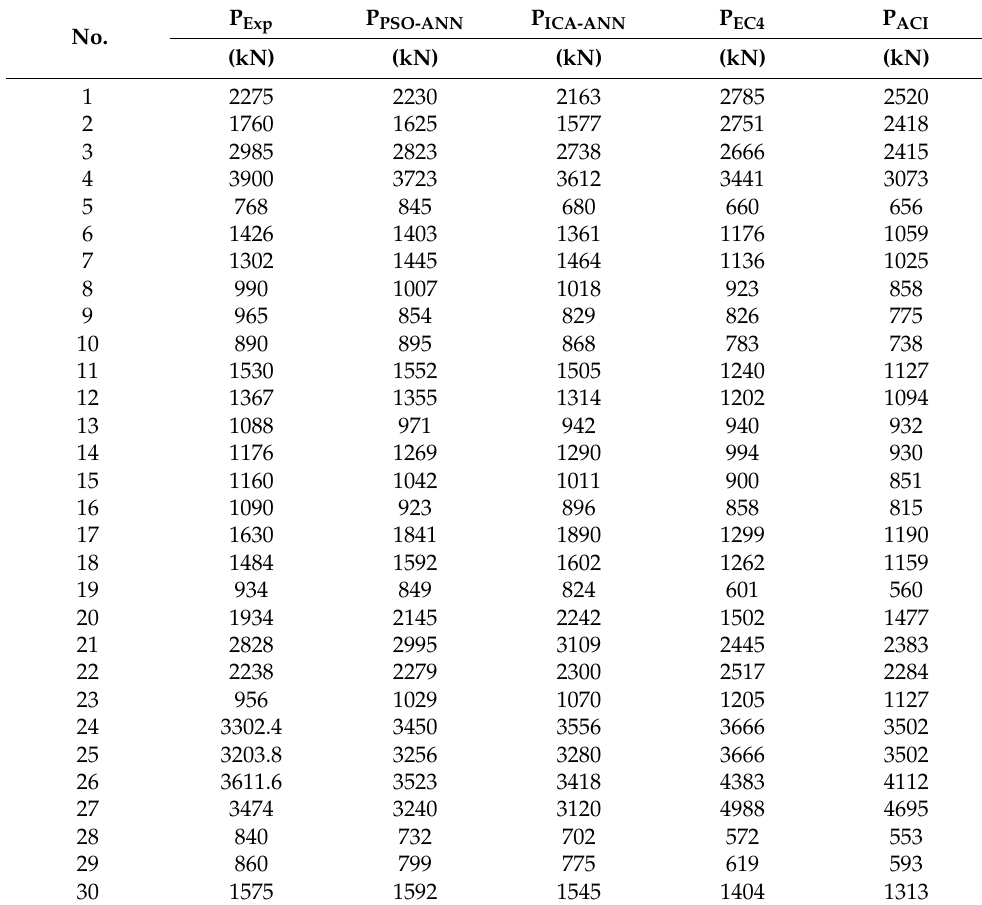
Table 4. Comparison of the experimental results with predicted